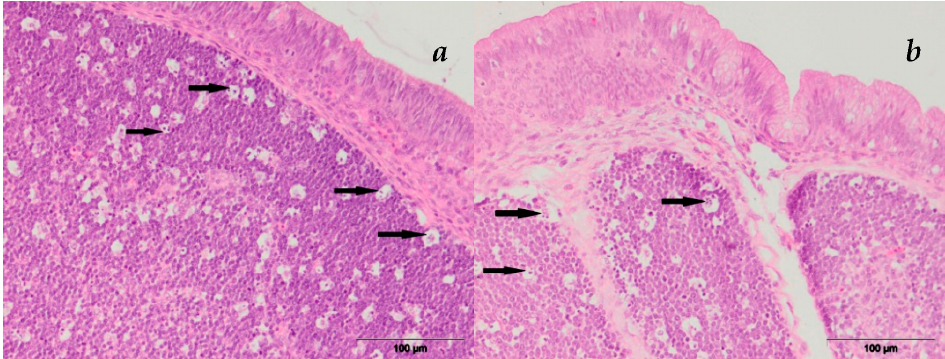
Figure 4. The apoptosis of Bursa Fabricii , HE staining: ( a ) group E‑V; ( b ) group E‑VI. Figure 4 . The apoptosis of Bursa Fabricii , HE staining: ( a ) group E-V; ( b ) group E-VI .